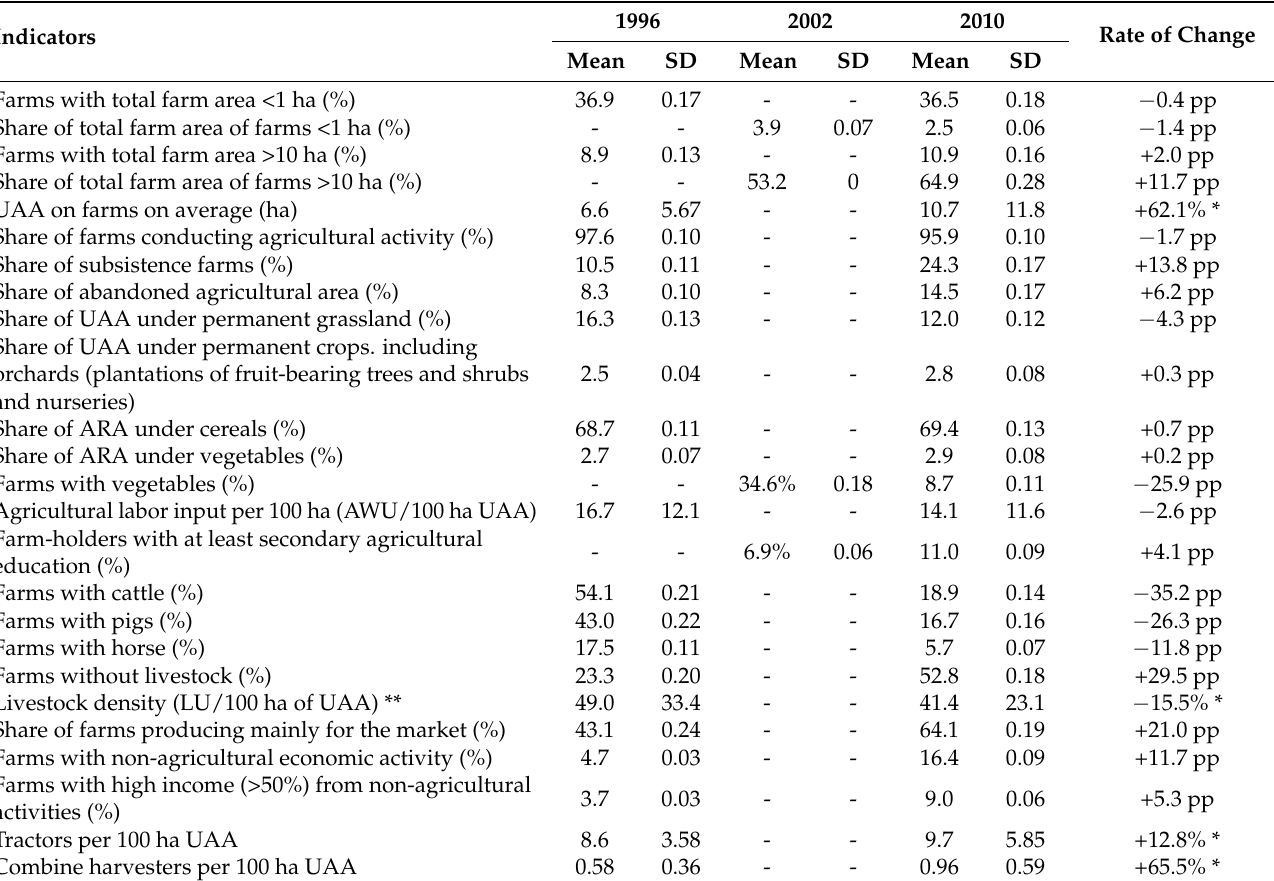
Table 2. Farming system indicators for Polish MAs ( n =